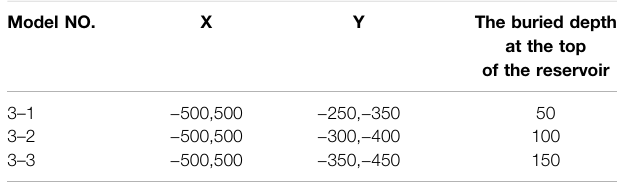
TABLE 4 | The model parameters of various buried depth at the top of the reservoir that needs to be compared. Model